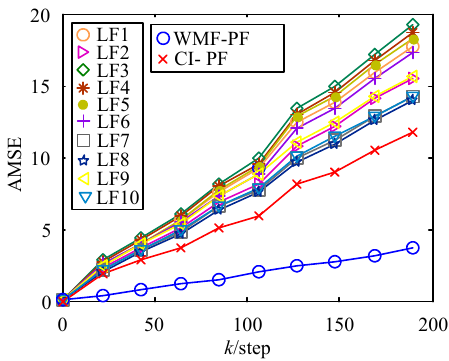
Figure 4. Accumulated mean square error (AMSE) curves of local particle filters (PFs), WMF-PF, and covariance intersection PF (CI-PF).